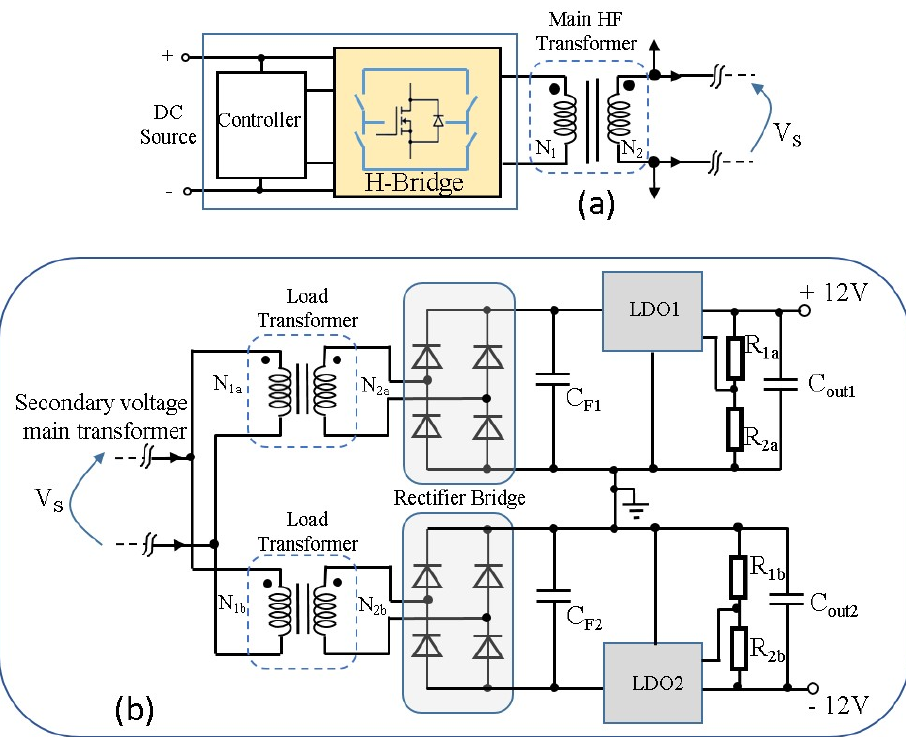
Figure A1. ( a ) The soft-switching auxiliary converter with the main HF transformer. ( b ) Current sensing power supply with the two load transformers for the positive and negative voltages request. source